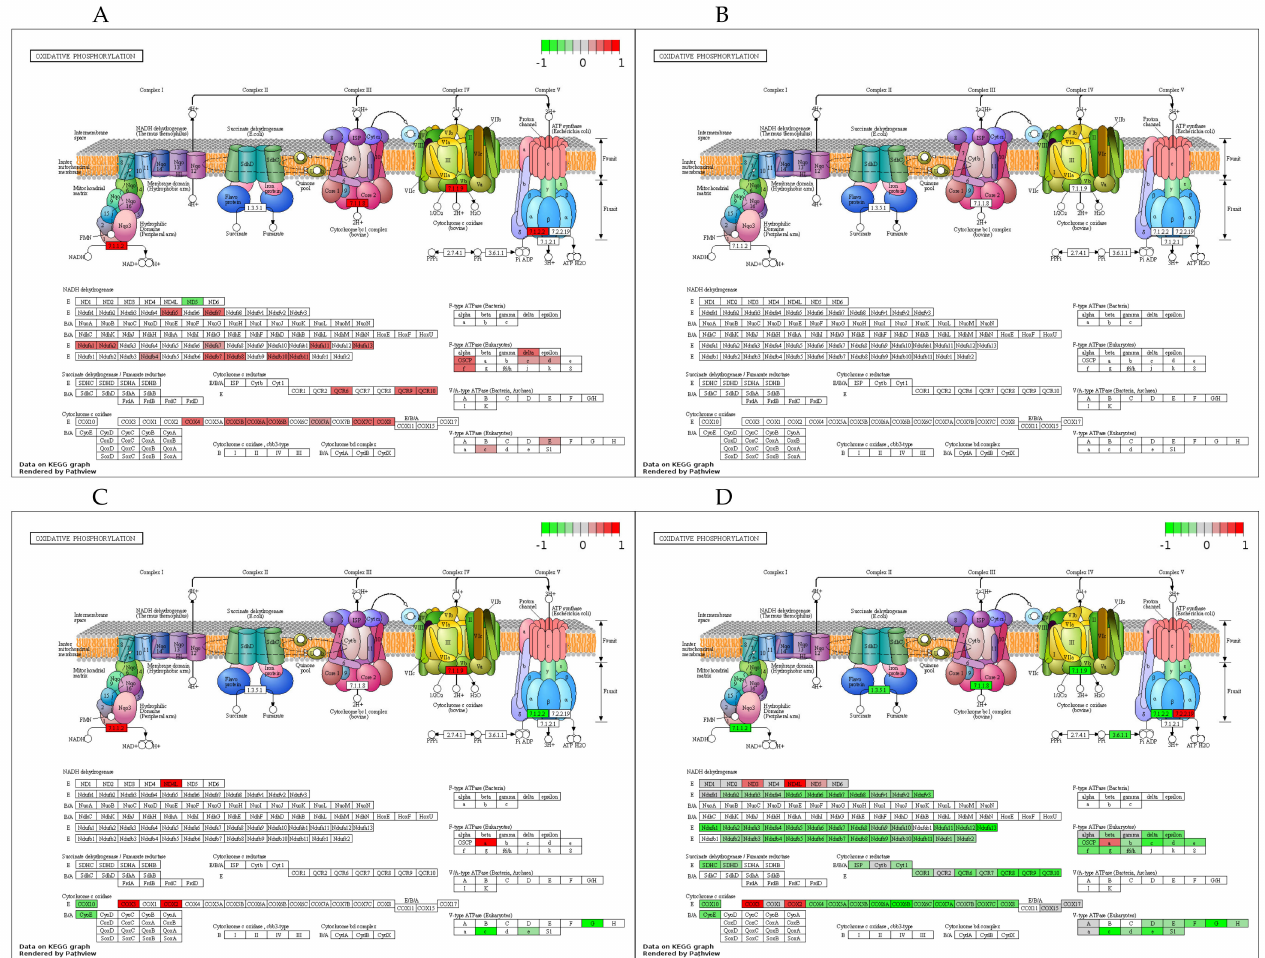
Figure 6. Regulation of oxidative phosphorylation in the pituitary gland influenced by selection and training. The KEGG pathway analyses were obtained by using the DEGs (FDR ≤ 0.05) of all comparison groups (( A ): DUC tr. vs. sed.; ( B ): DUhTP tr. vs. sed.; ( C ): DUhTP sed. vs. DUC sed.; ( D ): DUhTP tr. vs. DUC tr.) via https://pathview.uncc.edu (access date: 08/03/2021). Abbreviation: sed. = sedentary, tr. = trained, vs. =